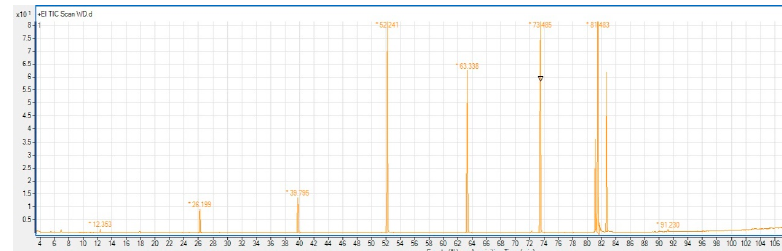
Figure 2. Chromatograms of the wafer sample.